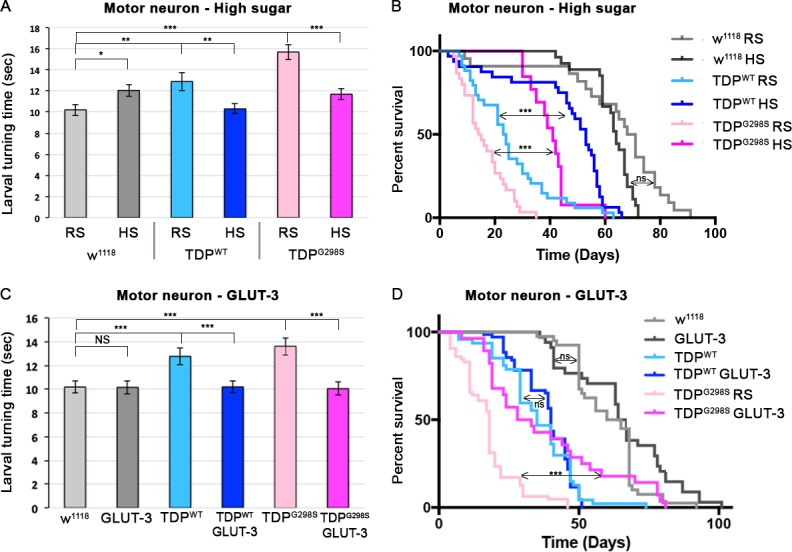
A high glucose diet rescues neuronal TDP-43 toxicity in flies.TDP-43WT or ALS associated TDP-43G298S were expressed in MNs (using GAL4-UAS). (A, B) Larval turning and lifespan assays for Drosophila fed a cornmeal based food containing either regular concentration of sugar (RS) or a high sugar diet (HS:10x the standard amount of sugar). (C, D) Larval turning and lifespan assays for Drosophila expressing GLUT-3 on its own or with TDP-43, as indicated. At least 30 larvae were tested in larval turning assays and on average 20 adults were assayed for survival. Kruskal-Wallis test and Log-rank (Mantel-Cox) test was used to determine statistical significance for larval turning and survival curve respectively. * - p<0.05, ** - p<0.01, *** - p<0.001.10.7554/eLife.45114.021Figure 4—source data 1.D4210x, 5x, 2x, 1x, 0x Glucose Larval Turning D42 AO; GLUT 3LT; GLUT3 survival; and HS survival.